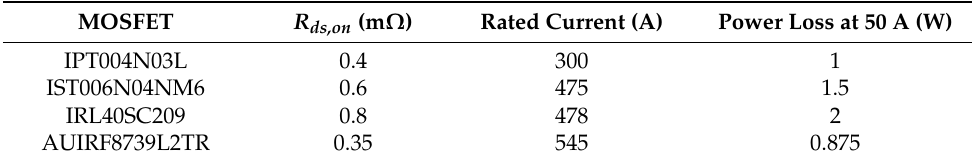
Table 1. Commercially available MOSFETs with very low on-resistance for minimizing the power loss in a Smart Battery.